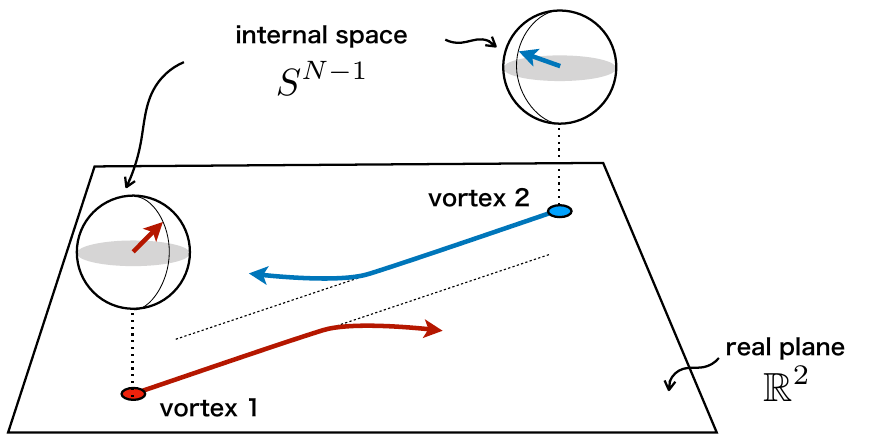
Figure 2 . Schematic picture of scattering of two non-Abelian vortices on the plane. Each vortex has its own internal orientation S N − 1